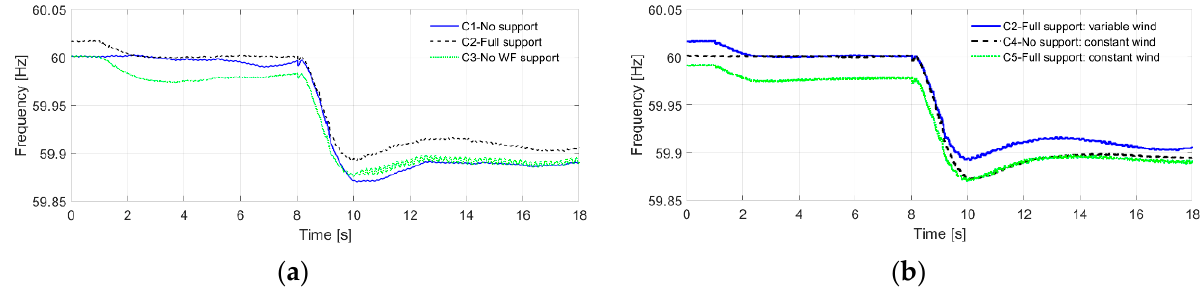
Figure 14. System frequency measured at the HPP point of connection: ( a ) variable wind speed; ( b ) constant wind speed compared to Case 2.